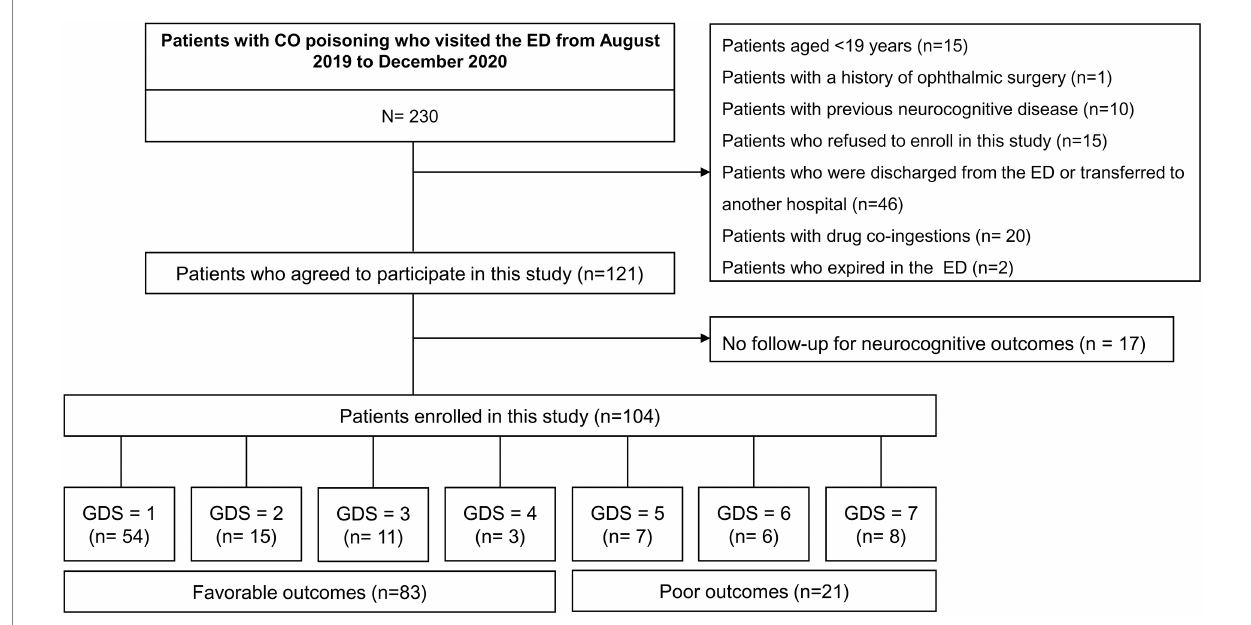
FIGURE 1 Study flow diagram. CO, carbon monoxide; ED, emergency department; GDS, global deterioration